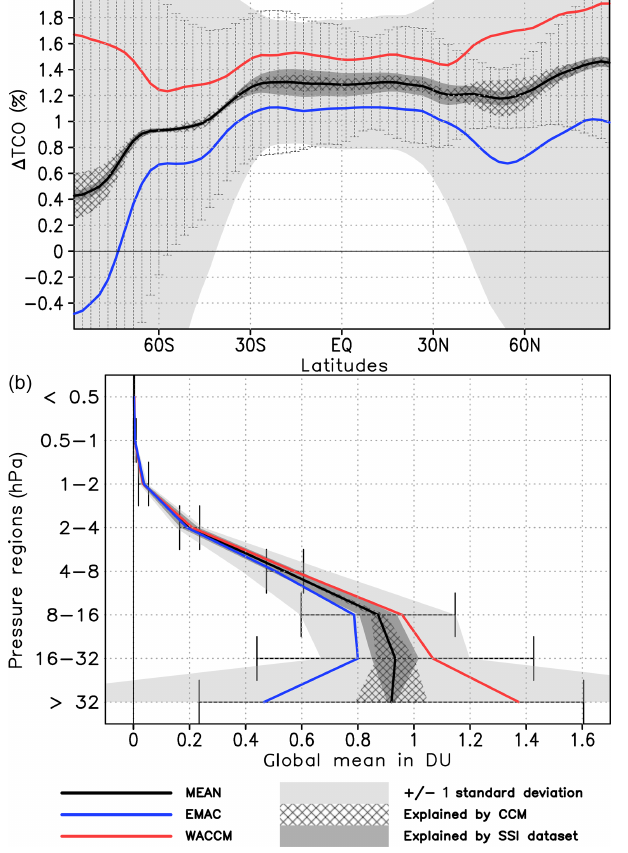
Figure 11. (a) Ensemble average, annual, and zonal mean 11-year solar cycle response in partial column ozone in percent (solid black) and the 95% confidence interval as error bars; WACCM simula- tions only (solid red); EMAC simulations only (solid blue); light grey shading denotes the standard deviation of the ensemble mean solar response; the hatched region denotes the part of the standard deviation explained by the models; dark shading denotes the part of the standard deviation explained by the SSI data sets. (b) As the top but for annual, global mean 11-year solar cycle response in TCO in DU (solid black) for pressure regions as indicated on the y